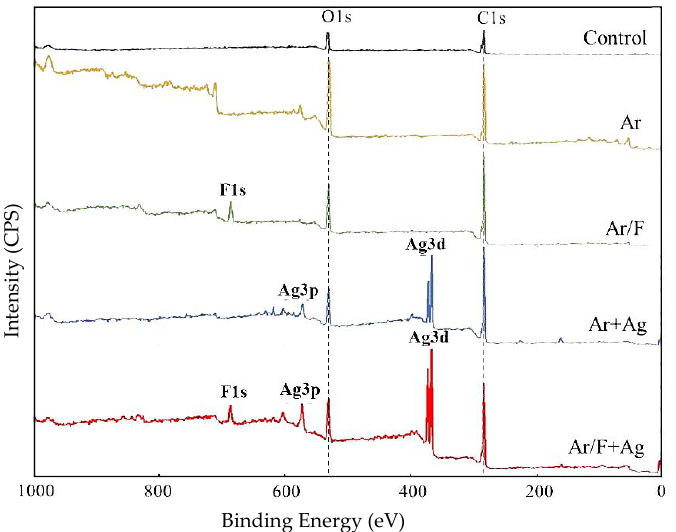
Figure 1. XPS wide-scan spectra from each PMMA group. Dashed lines indicate the peak positions of PMMA components. Bold characters indicate the peaks of implanted F and